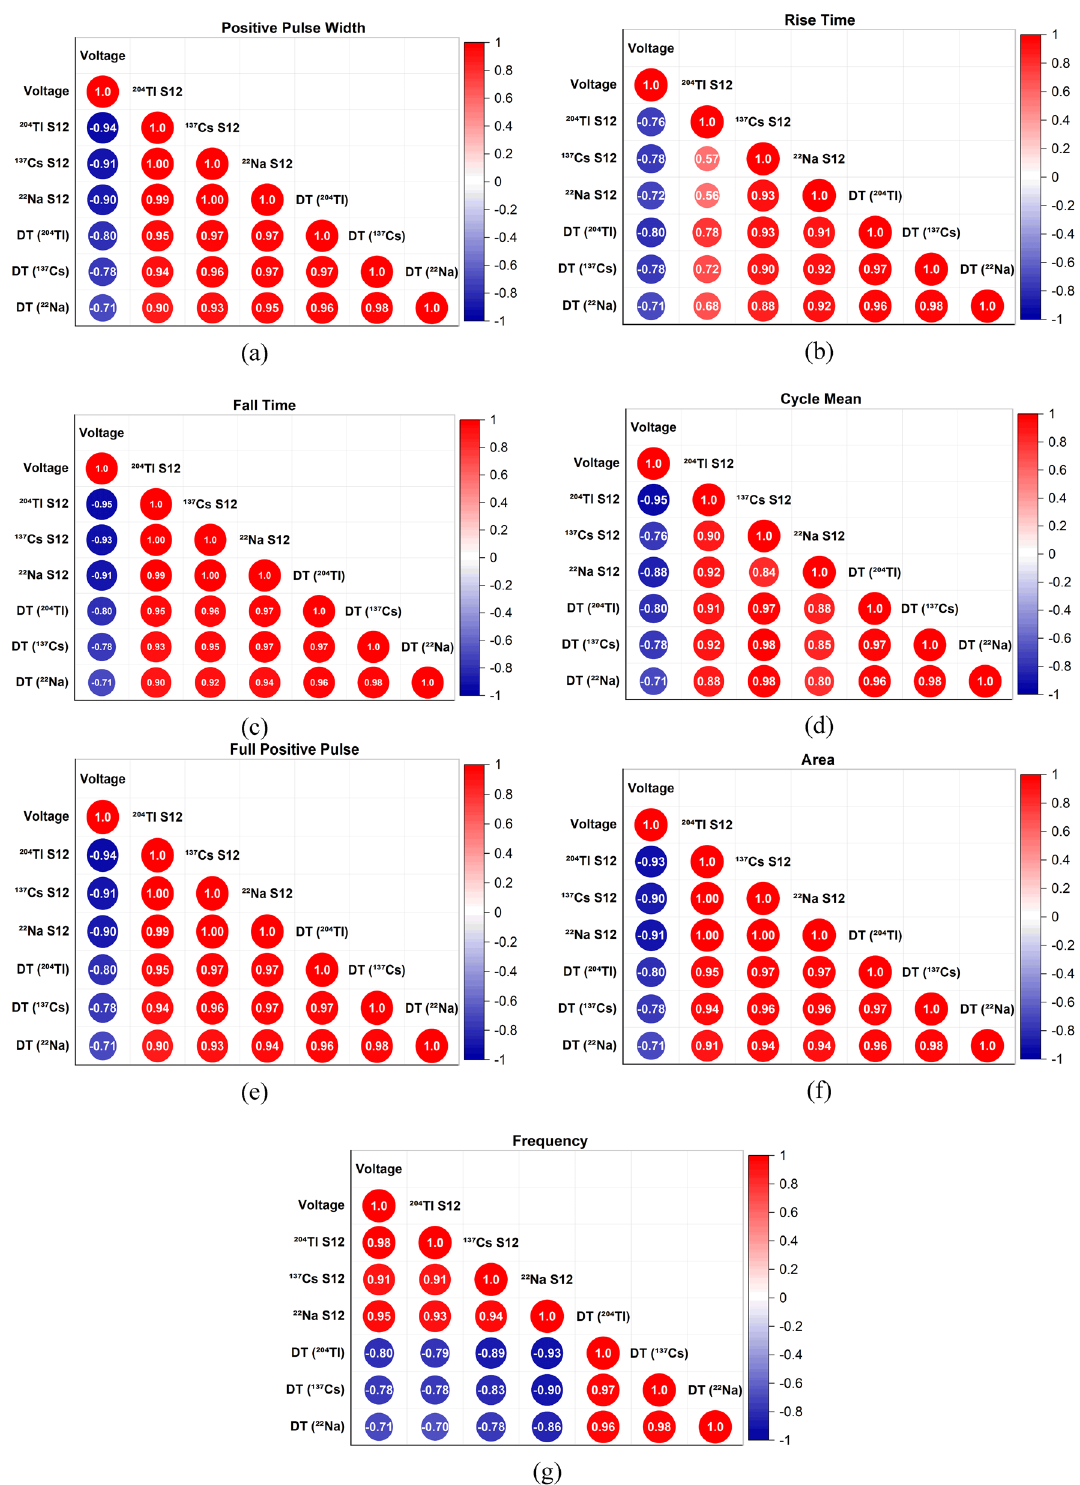
Figure 4. Correlation coefficients for pulse shape characteristics and operating voltages from 750 to 1200 V. S12 stands for combined radioactive sources. DT stands for